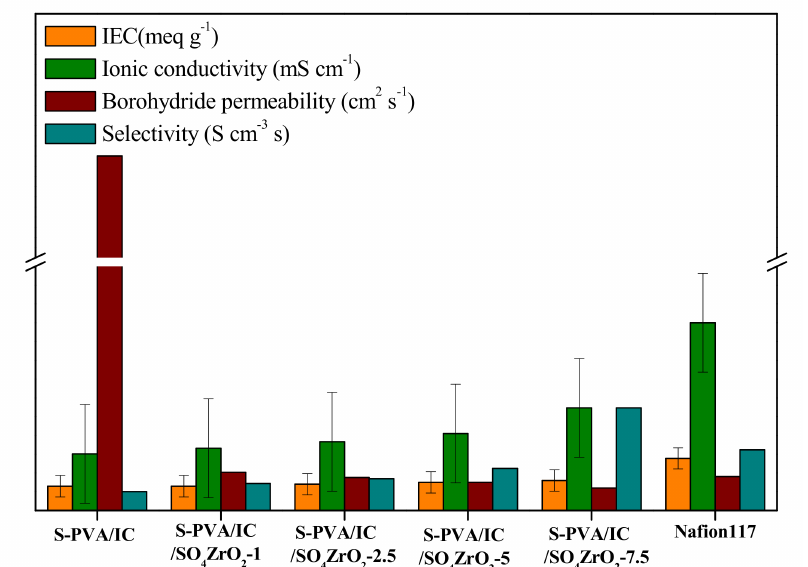
Figure 6. Ion exchange capacity, ionic conductivity, borohydride permeability, and selectivity of the fabricated membranes and Nafion 117.